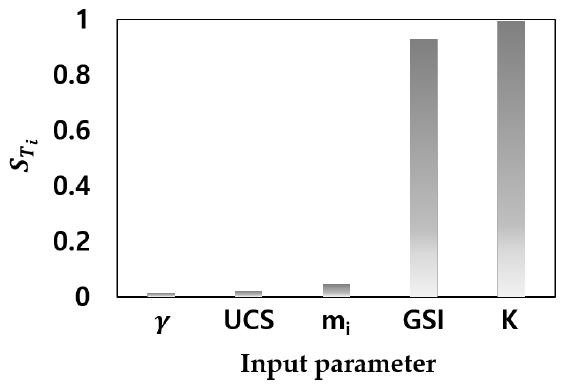
Figure 6. Results of global sensitivity analysis for five input parameters.